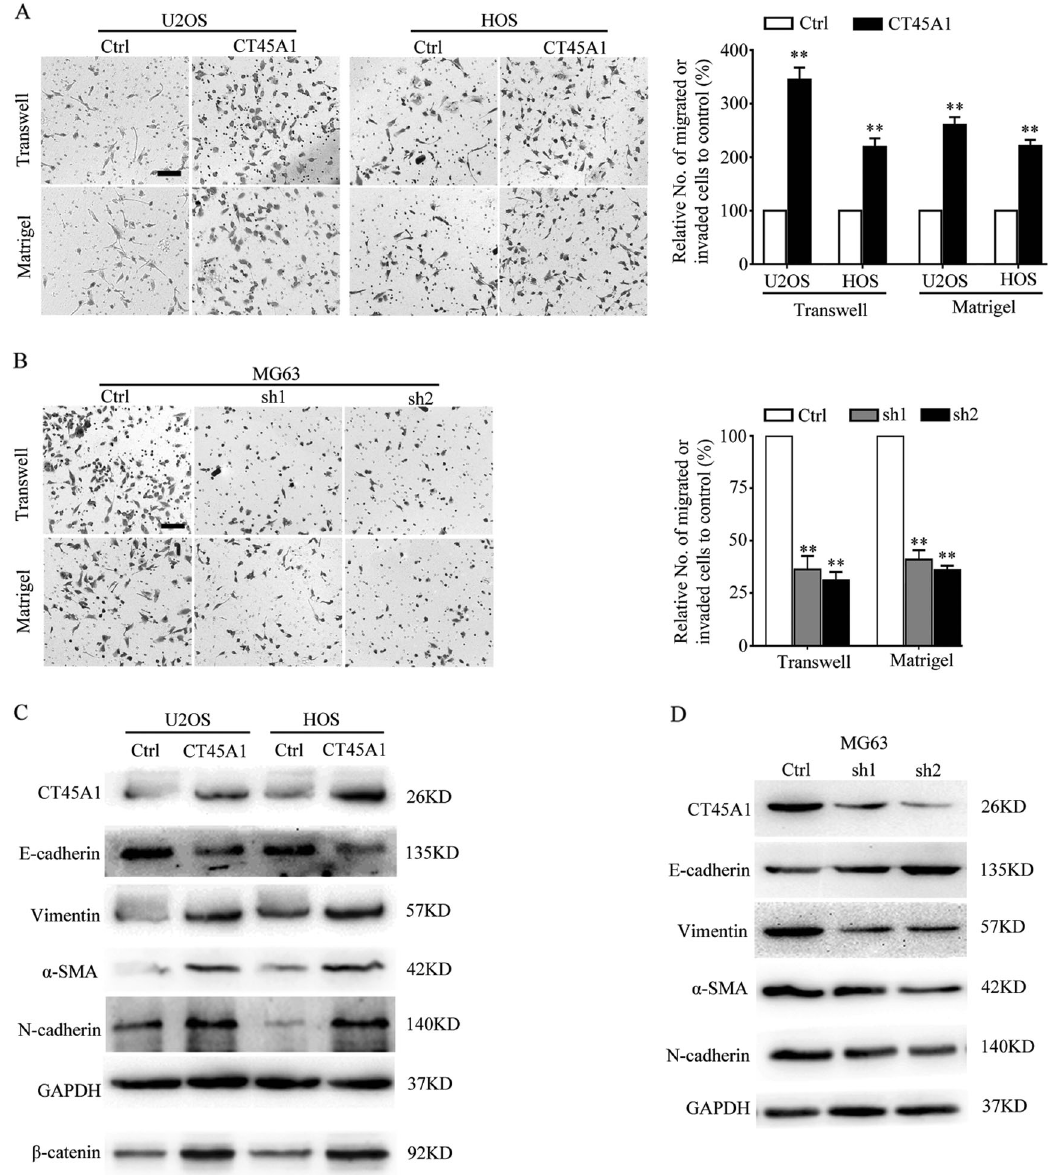
Fig. 4 CT45A1 promotes the metastasis of osteosarcoma cells in vitro by inducing EMT. A Transwell and martrigel assay of osteosarcoma cells with CT45A1 overexpression. B Transwell and martrigel assay of osteosarcoma cells with CT45A1 silencing. C Western blotting for the quanti fi cation of EMT markers in osteosarcoma cell lines with CT45A1 overexpression. D Western blotting of EMT markers in osteosarcoma cell lines with CT45A1 silencing. Scale bars: 100 μ m ( A , B ). ** P < 0.01, compared to the control. The error bars indicate the means ±